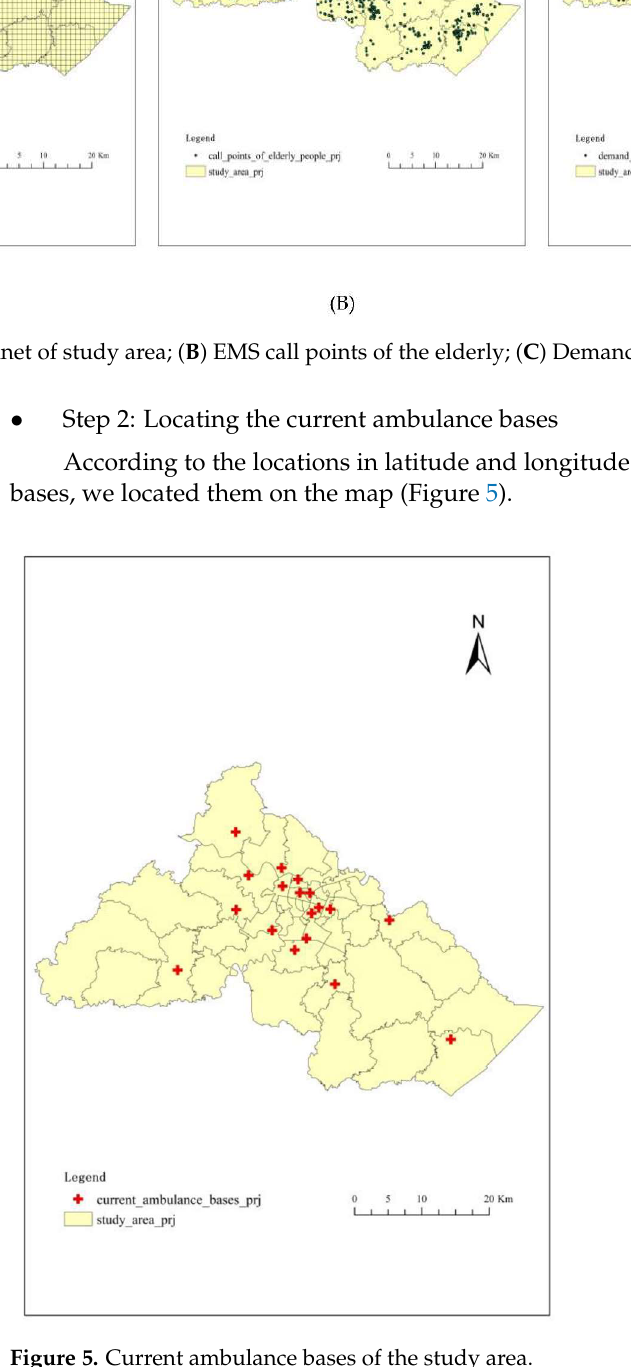
Figure 5. Current ambulance bases of the study area.